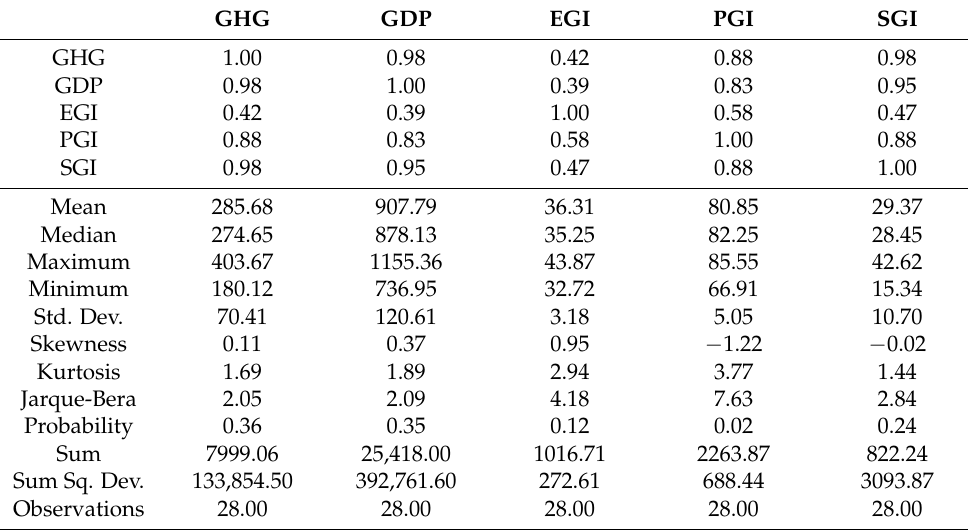
Table 1. Correlation and descriptive analysis of the